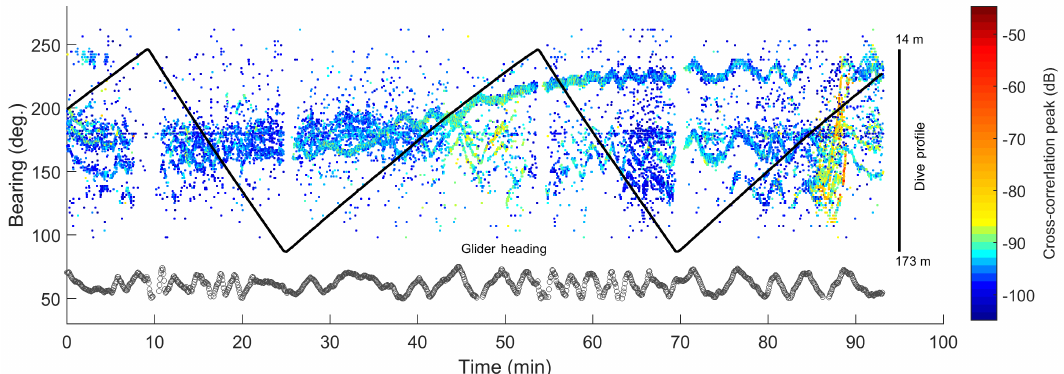
Figure 16. Estimated bearing angles (ambiguous angles are not shown) relative to the glider of all clicks detected in file 06 as a function of time and cross-correlation peak strength (colorbar). The glider’s heading is shown below (shifted up by 50 ◦ ), and the glider’s dive profile (black zigzag) is superimposed for reference.